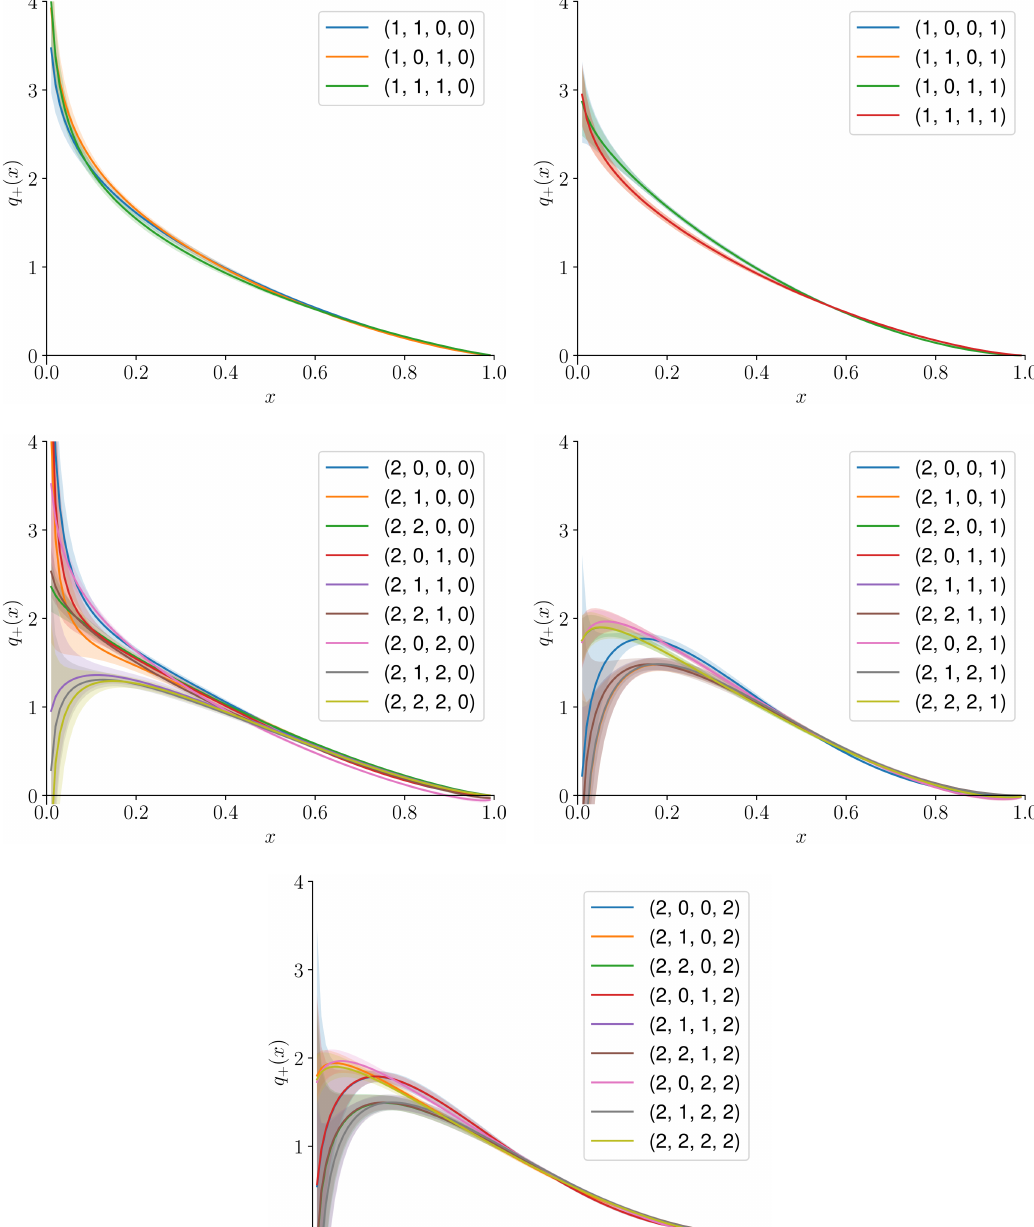
Figure 17 . The PDF results from fitting the imaginary component to the models. The numbers in the legend correspond to ( N ± , N